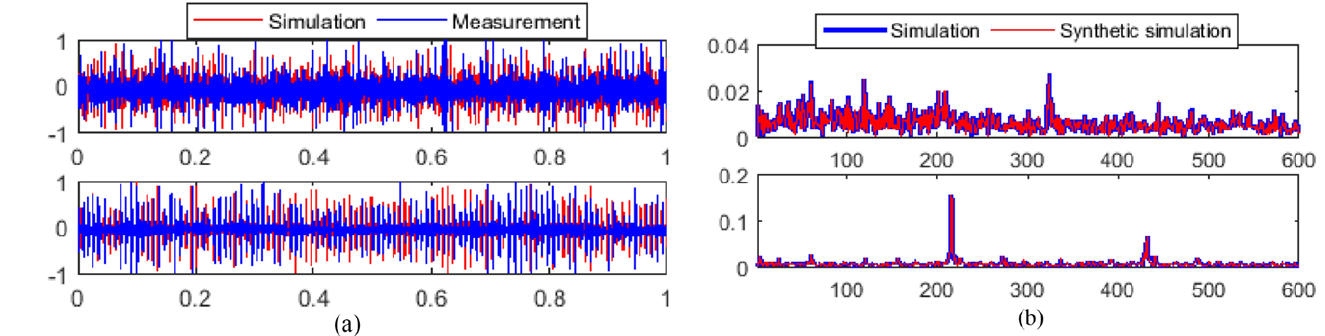
Figure 49. Inner race and outer race bearing results were obtained by ( a ) experimental data and ( b ) synthetic data. Reproduced with permission of [125]. ( b ) synthetic data. Reproduced with permission of